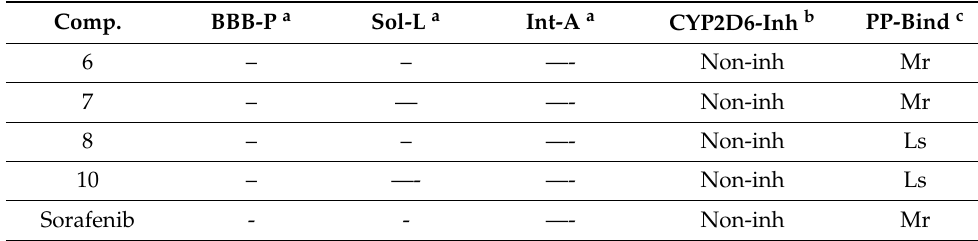
Table 6. ADMET profile (calculated) of the examined compounds. Comp.